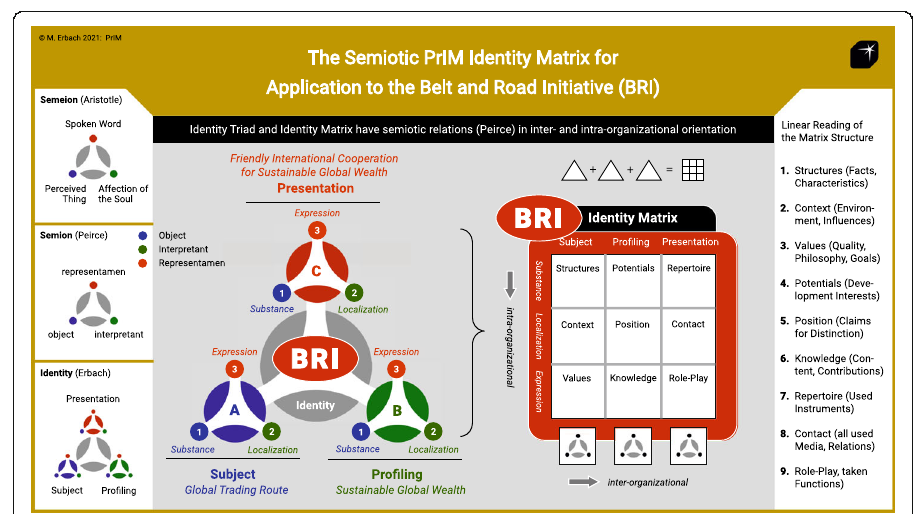
Fig. 6 The PrIM Identity Matrix for application to the Belt and Road